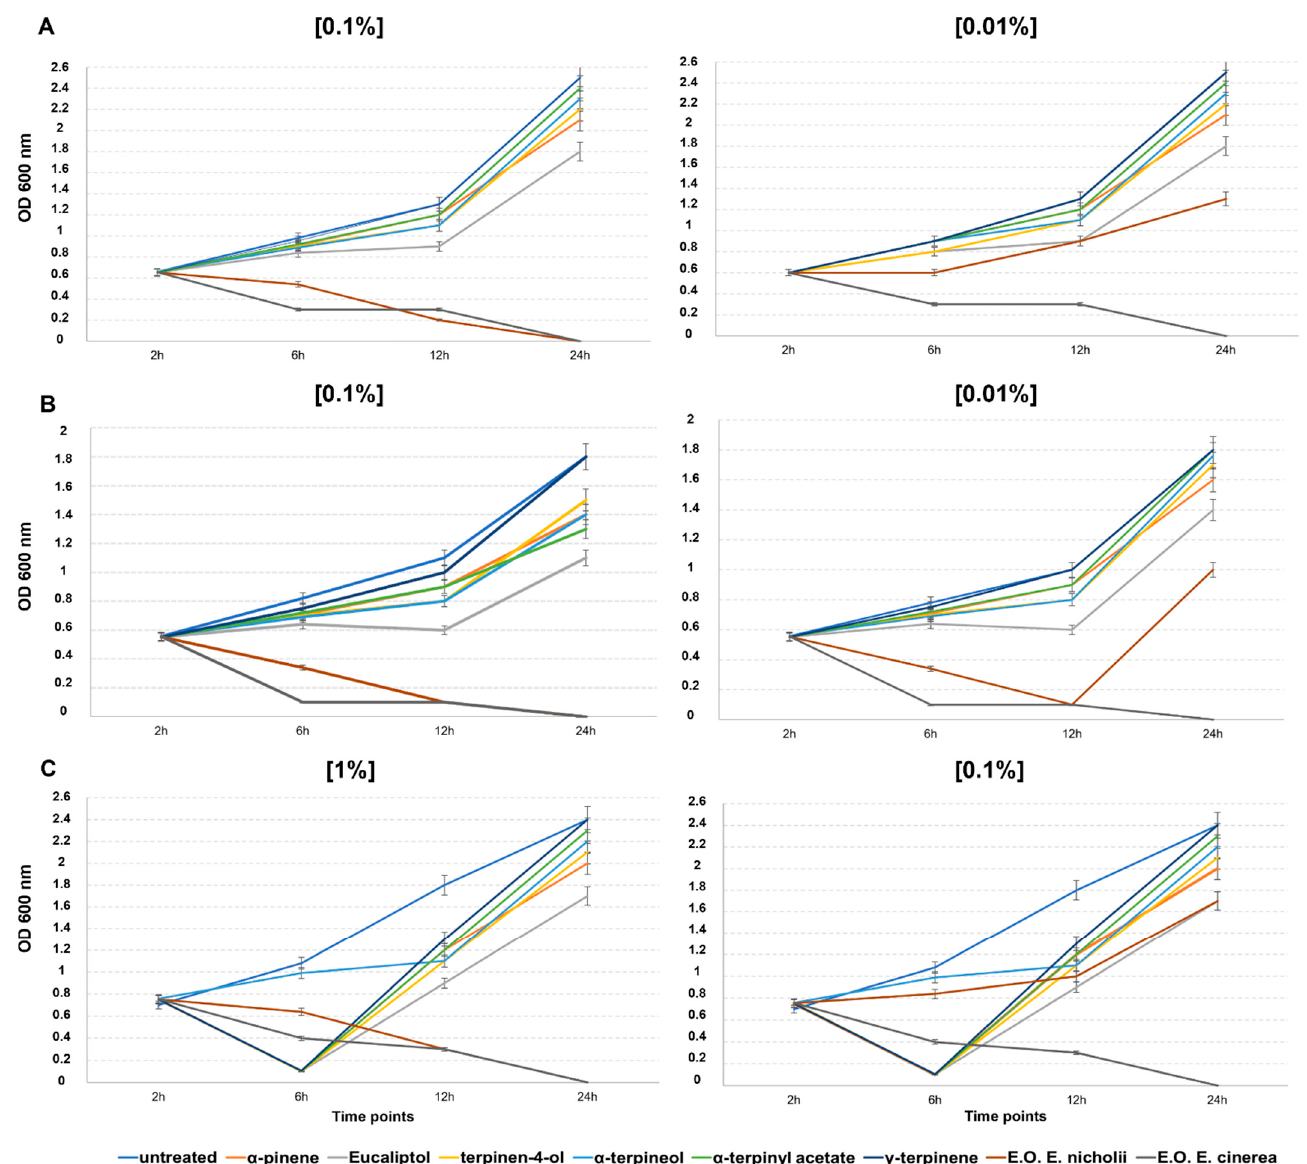
Figure 4. Antibacterial activity of different concentrations (0, 0.01, 0.1, and 1% v/v ) of EOs extracted from E. cinerea or E. nicholii , and six pure EO compounds on the culture growth of: ( A ) Xanthomonas campestris pv. campestris , ( B ) Enterobacter cloacae , and ( C ) Citrobacter freundii 24 h after treatment.